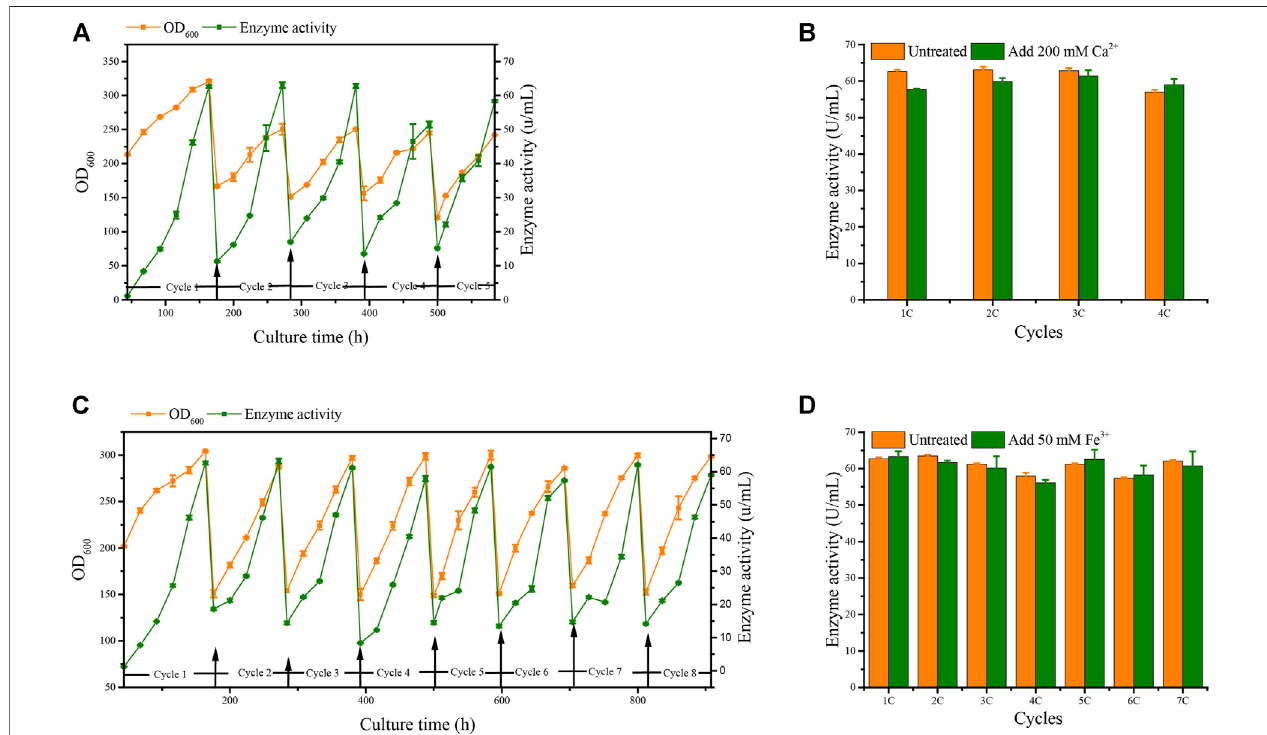
FIGURE 7 | Adding metal ions to accelerate cell sedimentation to recycle cells for semi-continuous cultivation. (A) Growth curve and enzyme activity after adding 200 mMCa 2+ ionstoaccelerateG/Pelsedimentationtorecyclecells. (B) Comparisonbetweentheuntreatedgroupandafteradding200 mMCa 2+ ionstoaccelerateG/ Pel sedimentation to recycle cells. (C) Growth curve and enzyme activity curve after adding 50 mM Fe 3+ ions to accelerate G/Pel sedimentation to recycle cells. (D) Comparison between the untreated group and after adding 50 mM Fe 3+ ions to accelerate G/Pel sedimentation to recycle cells.